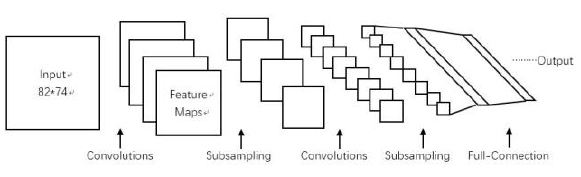
Figure 3. Structure of CNN